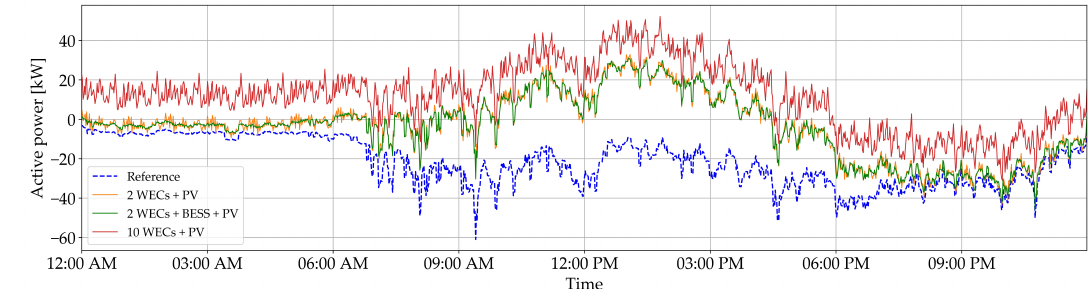
Figure 17. Active power exchange of the LVTF and upstream network at the swing bus for various scenarios in case study 2.